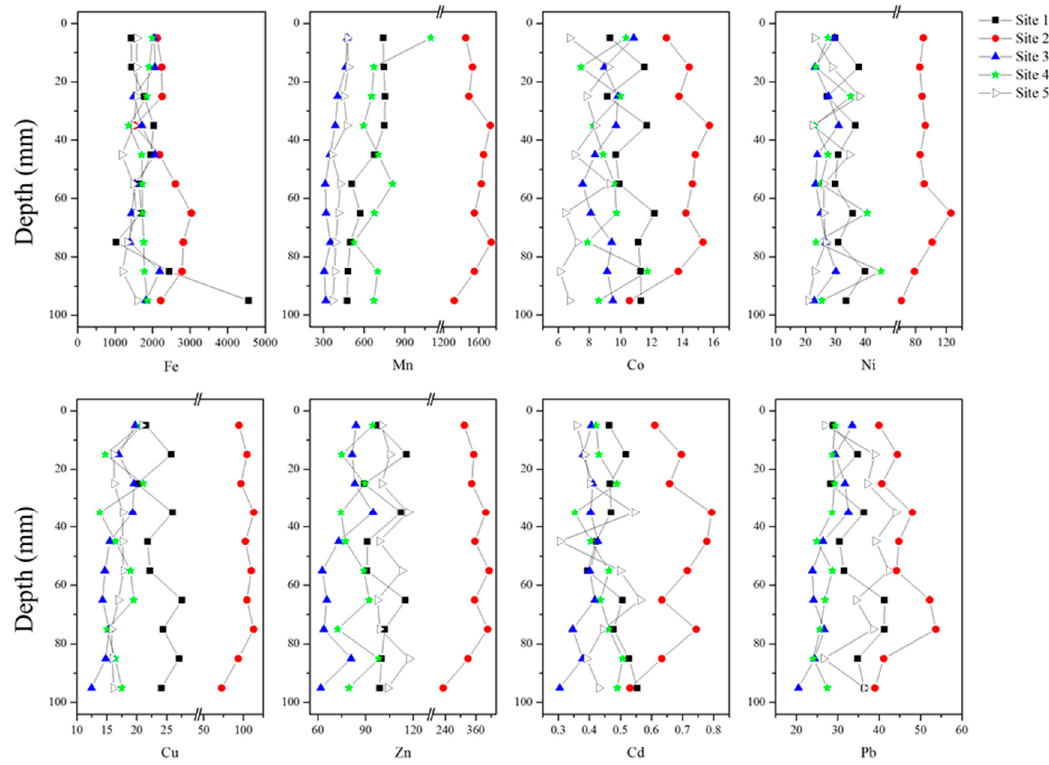
Figure 3. Distributions of total metal concentrations in sediments of five sites in Lake Taihu.